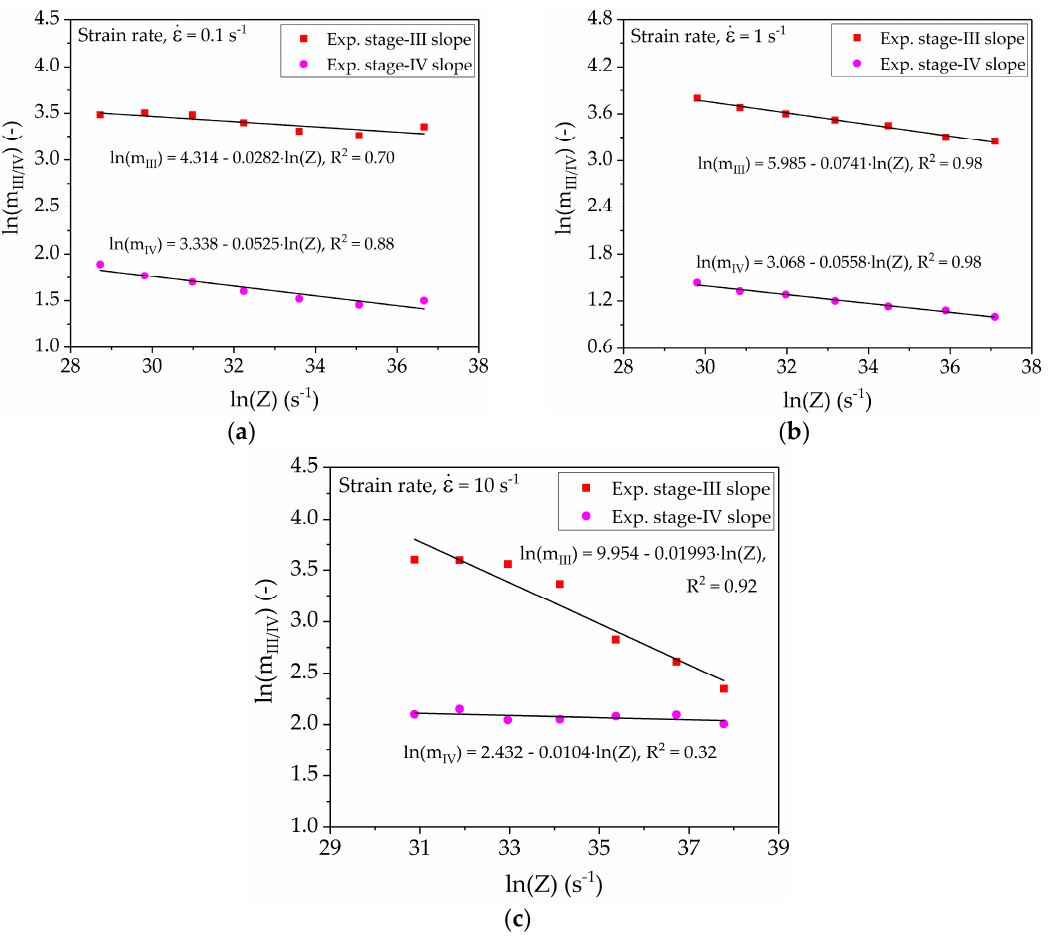
Figure 7. Relationship between slope of stage III ( m III ), stage IV ( m IV ), and Zener-Hollomon-parameter at strain rate of ( a ) 0.1 s − 1 ; ( b ) 1 s − 1 ; and ( c ) 10 s − 1 .